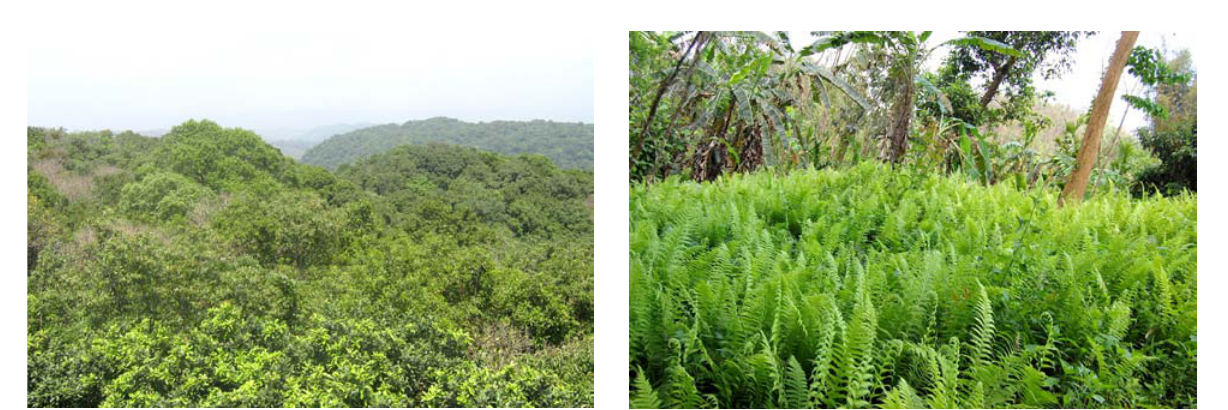
Image 1. Core area of Nokrek Biosphere Reserve Image 2. View of Luxurient growth of pteridophyte in